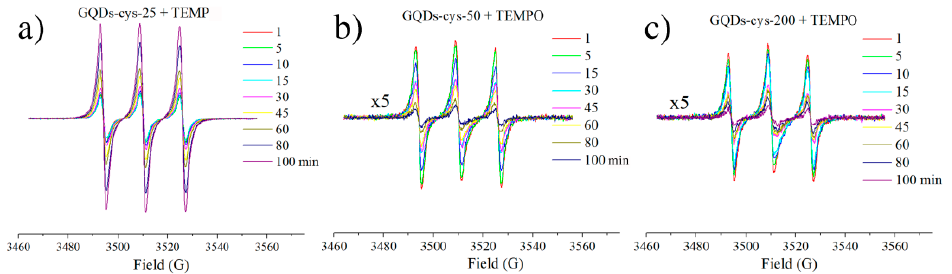
Figure 7. EPR spectra of light illuminated (1–100 min) GQD-cys-25 incubated with 30 mM TEMP ( a ), and GQD-cys-50 ( b ), and GQD-cys-200 ( c ) incubated with 3 mM TEMPO.